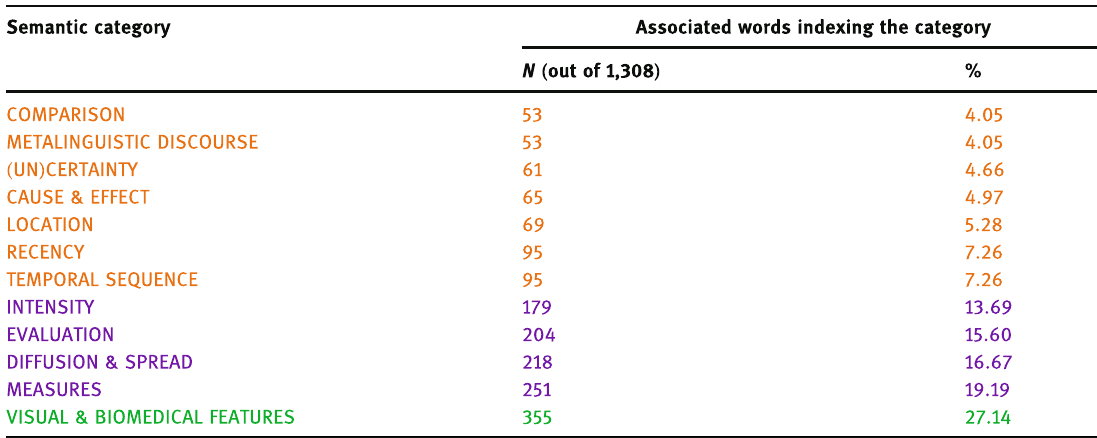
Table 5: Number and proportion of the 1,308 associated terms indexing a particular category, ordered by frequency of occurrence; color coded into categories that statistically group